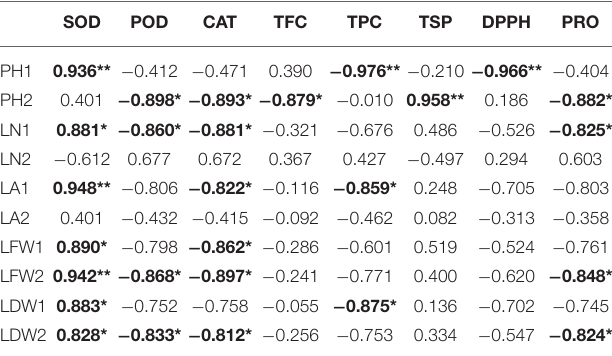
TABLE 5 | Correlation matrix of morphological and biochemical attributes in guava cultivars under drought stress. SOD